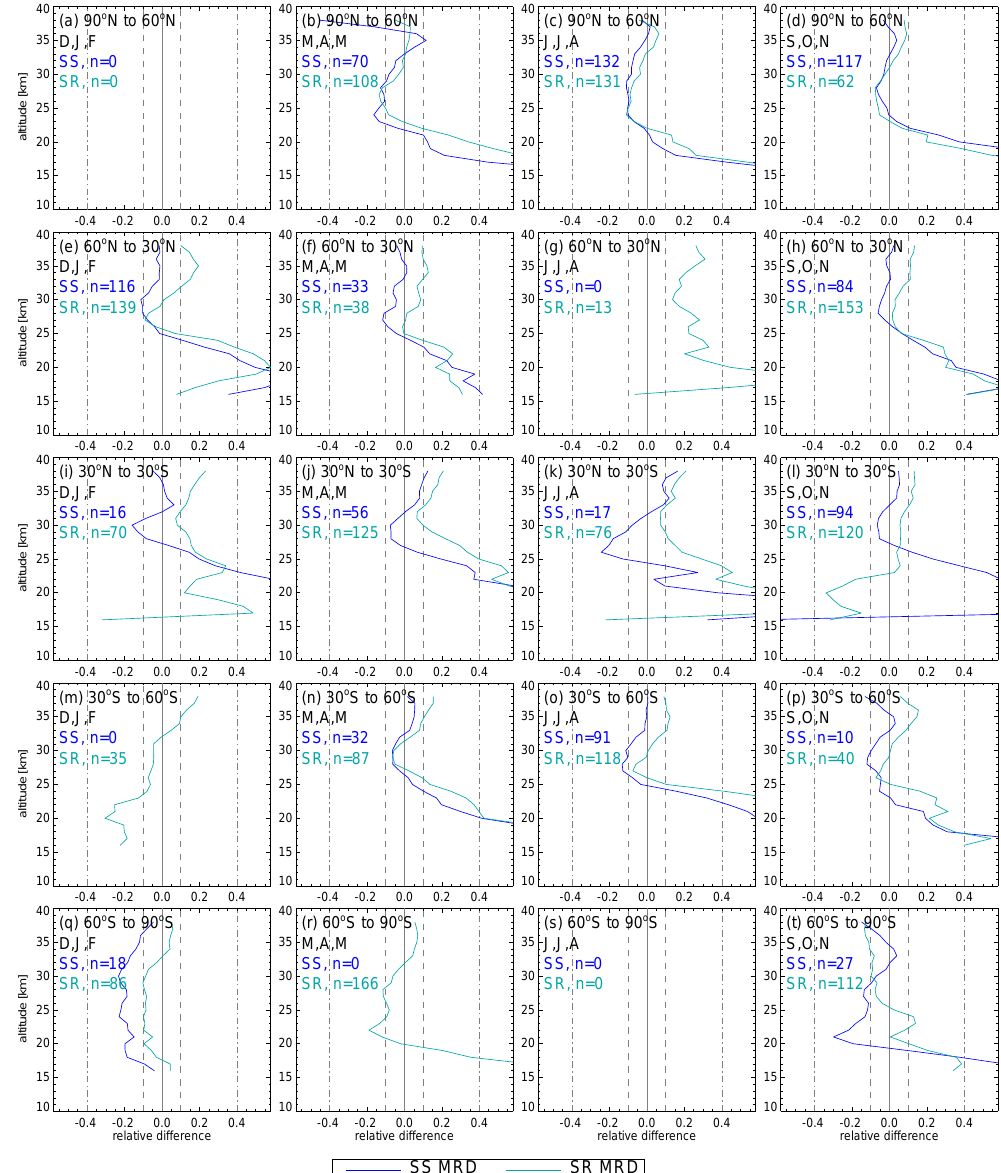
Fig. 13. MRDs between SCIAMACHY and photochemically corrected HALOE NO 2 profiles are displayed as blue (sunset) and cyan (sun- rise) solid lines for each latitude and